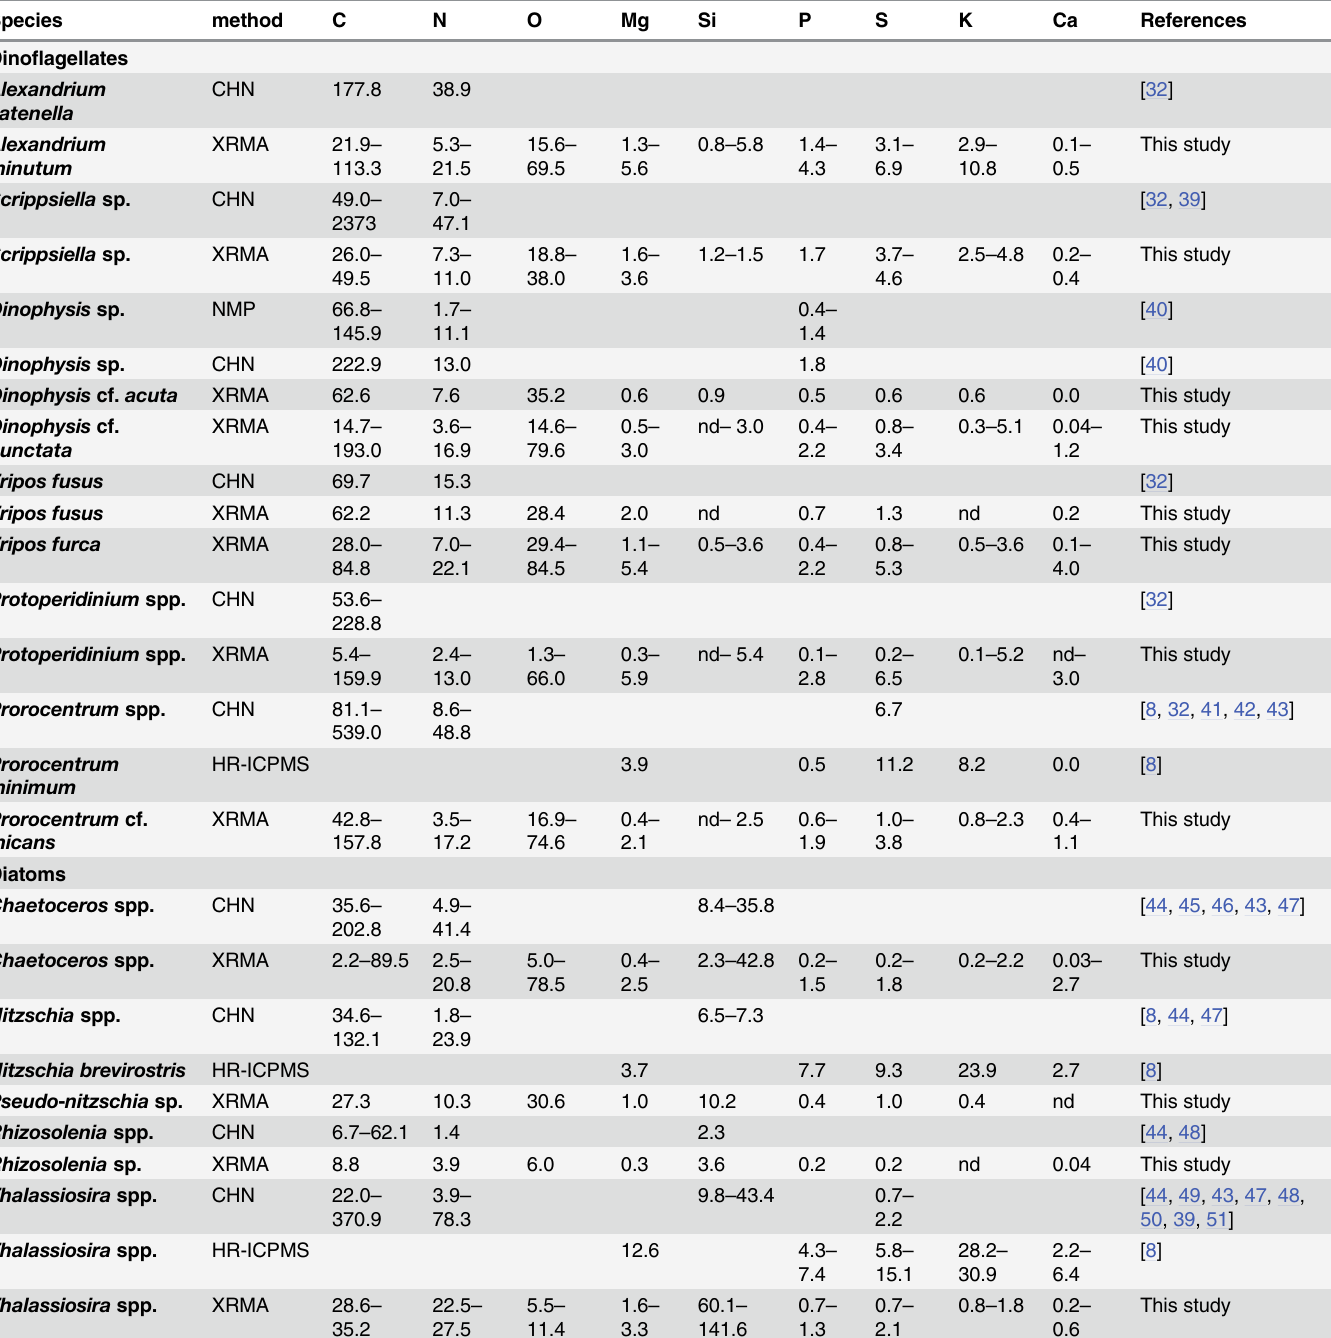
Table 2. Comparison between the elemental concentration (fg μ m -3 ) of diatoms and dinoflagellates of the same or close genera analysed with bulk analysis techniques (CHN and HR-ICPMS) and single-cell methods (NMP and XRMA). Single-cell data presented in this table corresponds to the range of individual measurements of cells of the same